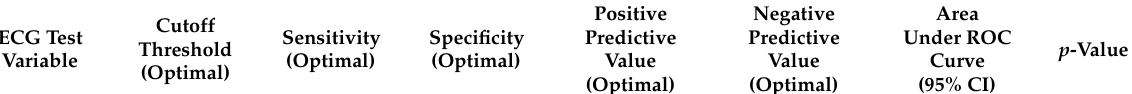
Table 3. Receiver operating characteristic (ROC) analysis for T/R ratio by lead, PR, and QRS.